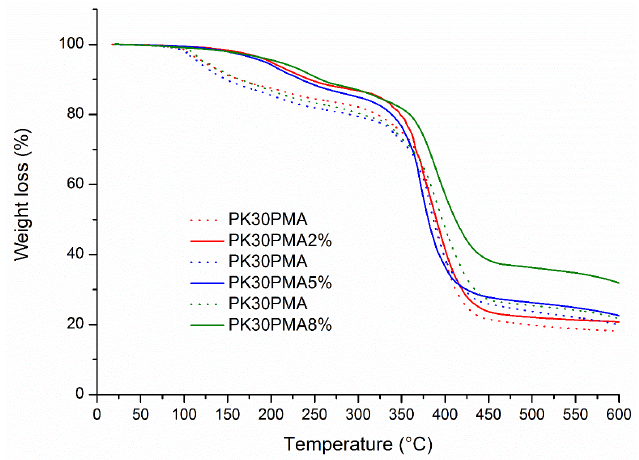
Figure 2. TGA curves of PK30PMA nanocomposites containing the 2, 5, and 8 wt % of MWCNTs.